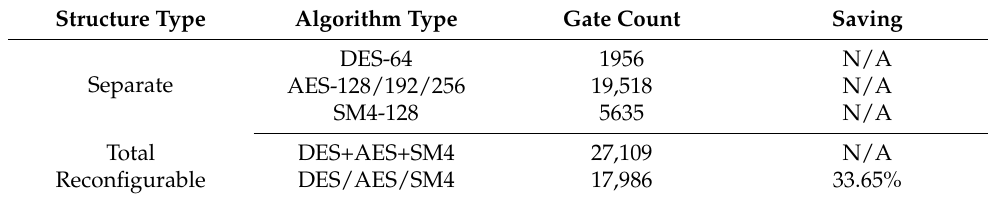
Table 6. Hardware overhead of separate hardware implementation and reconfigurable implementa- tion of the three block ciphers in 65